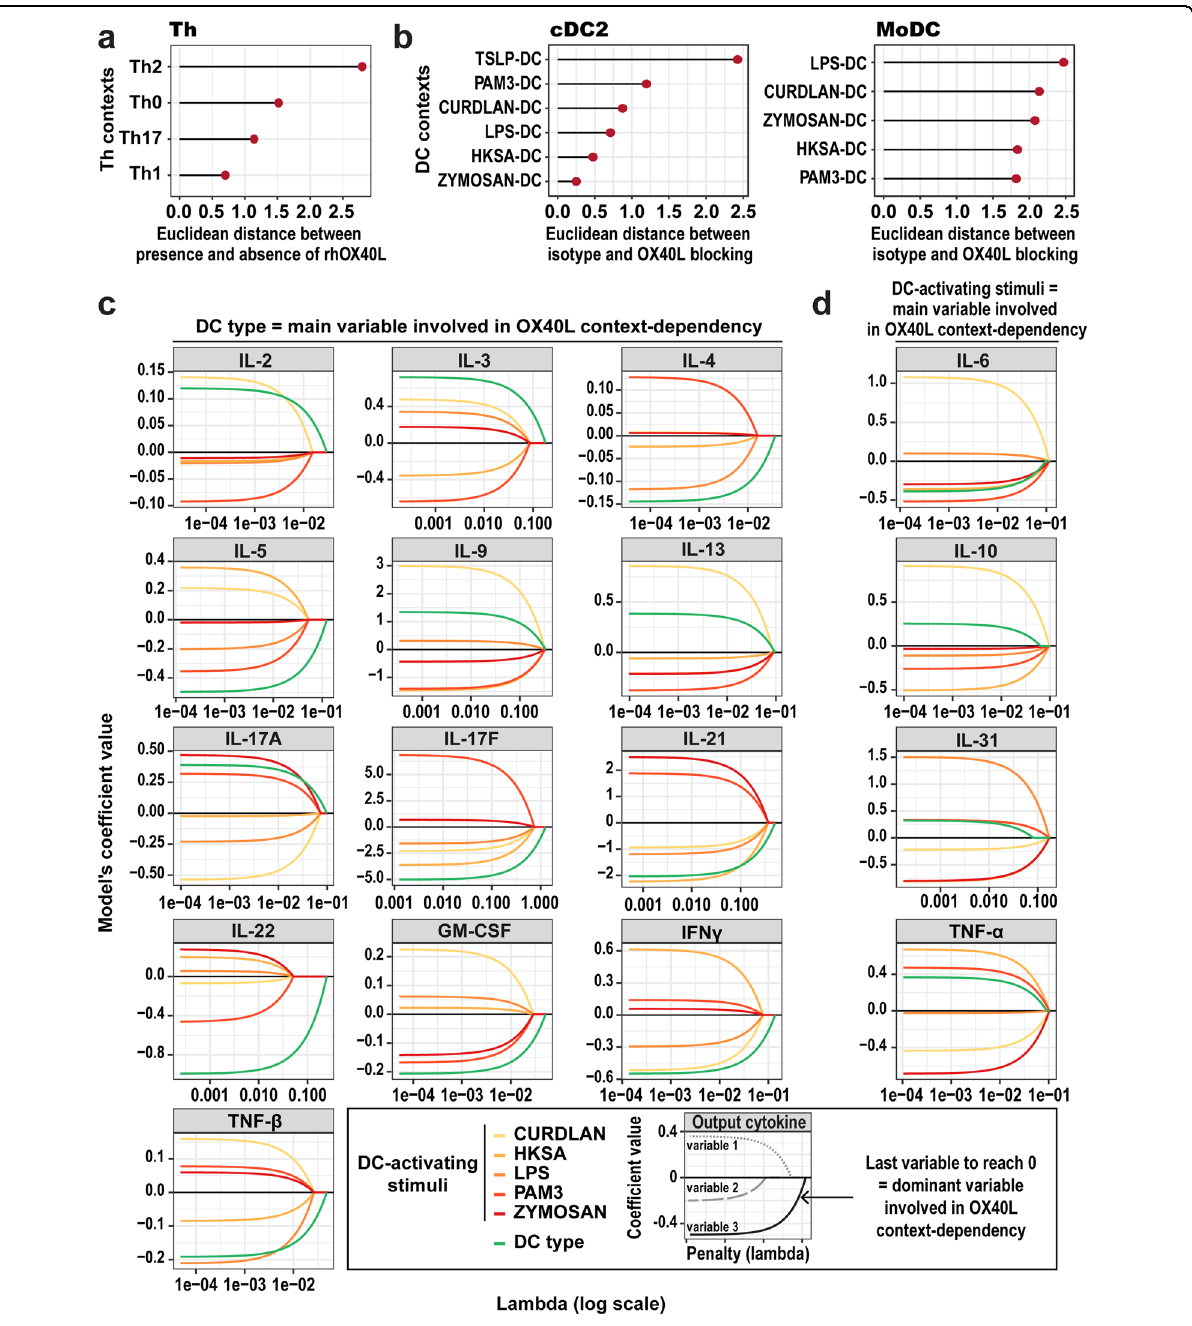
Fig. 7 OX40L context-dependency depends mainly on the DC type. a Euclidean distance between presence and absence of rhOX40L for each Th context, calculated from the 17 PCs of the PCA of the raw data (all cytokines). Thirteen independent donors were used in the analysis. b Euclidean distance between presence (isotype) and absence (OX40L-blocking antibody) of OX40L on DCs for each cDC2 and MoDC context based on a PCA of the 17 Th-cytokines measured (17 PCs). Nine independent donors were used in the analysis. c , d For each of the 17 output Th-cytokines measured in DC – T cocultures, group-lasso coef fi cients as a function of the penalization parameter (lambda) are represented. c Cytokines for which OX40L context- dependency was predominantly due to the DC type. d Cytokines for which OX40L context-dependency was predominantly due to the DC